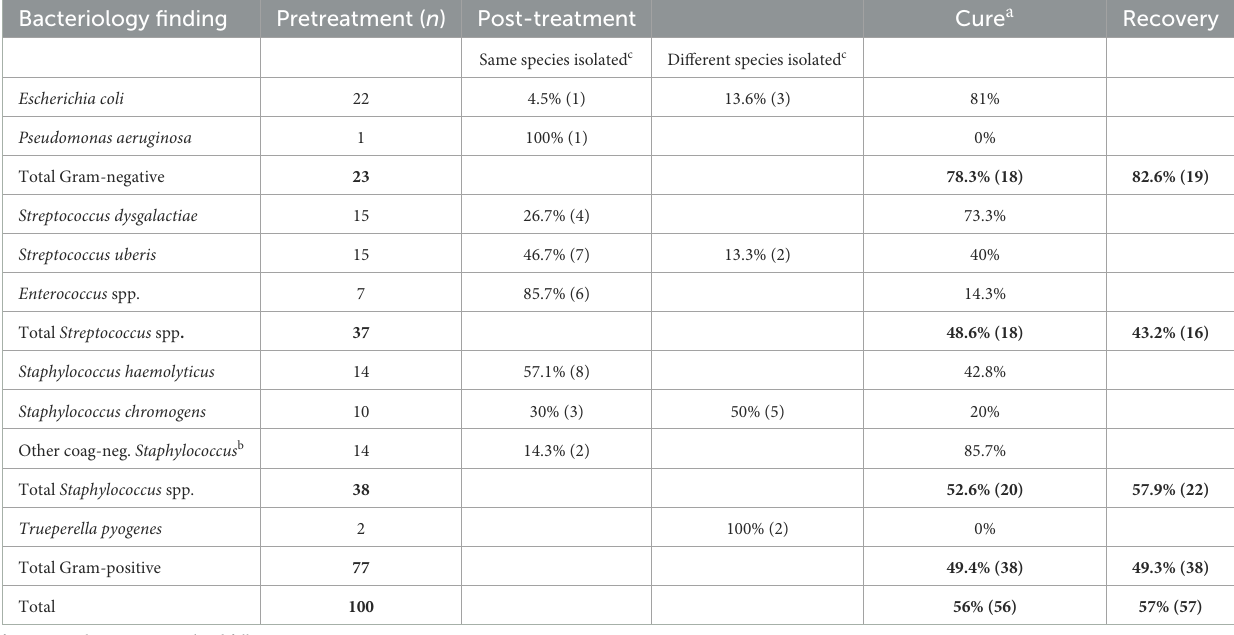
TABLE 1 Bacterial species found in Groups 2 and 3 ( n = 100) before APT treatment, rates of same or different findings following treatment, respective cures at 20–25 days, and recovery rates up to 3 months. Bacteriology finding Pretreatment ( n ) Post-treatment Cure a Recovery Same species isolated c Different species isolated